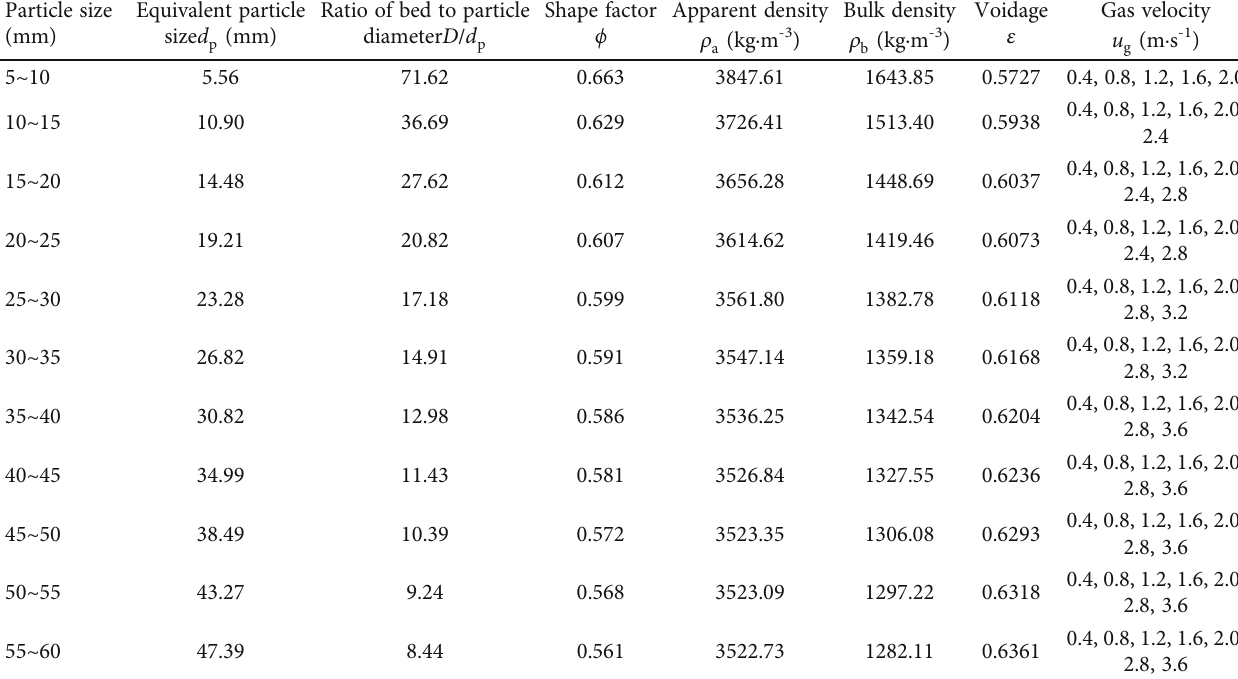
Table 2: Particle characteristic parameters and test conditions for 11 kinds of